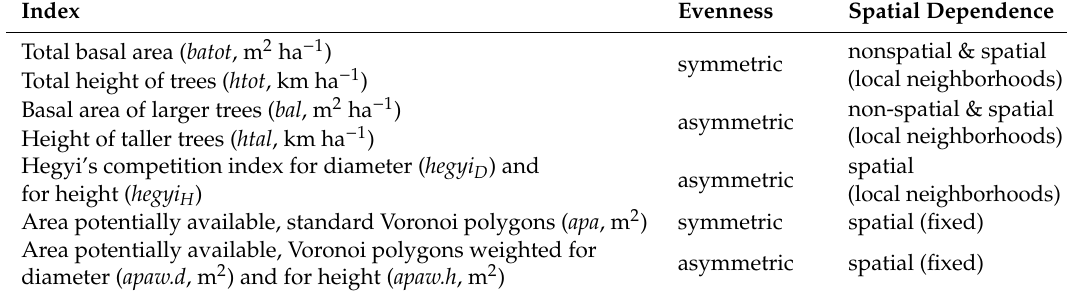
Table 2. Competition and growing space indices tested. Local neighborhoods include plots of 100, 200, and 300 m 2 .